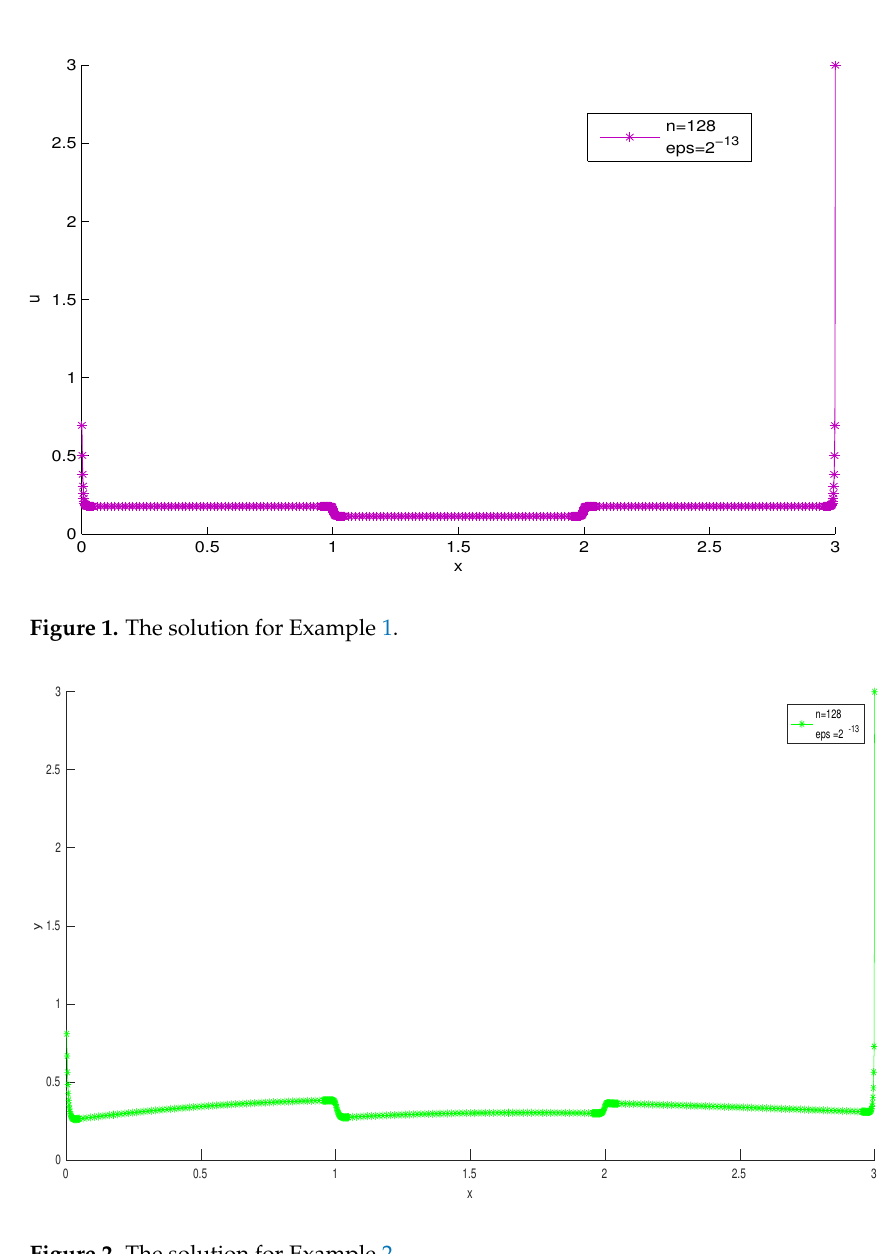
Figure 2. The solution for Example